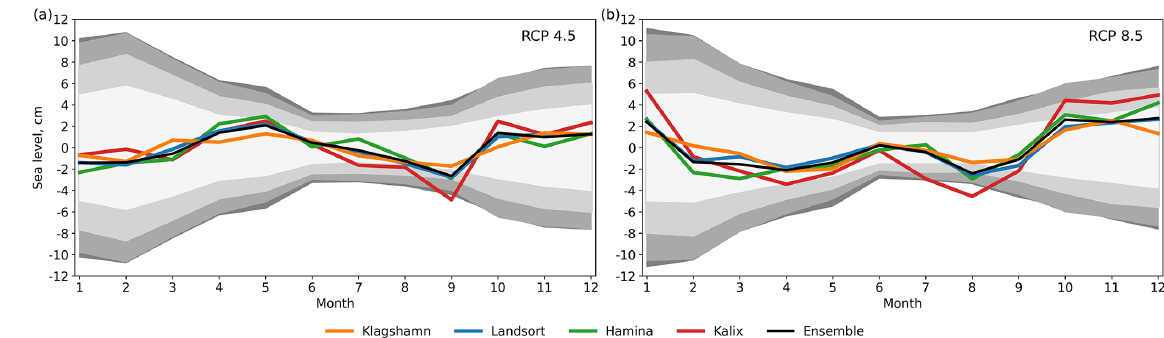
Figure 20. Monthly mean sea level changes between 1976–2005 and 2069–2098 at Klagshamn, Landsort, Hamina and Kalix (for the locations, see Fig. 1) for RCP4.5 (a) and RCP8.5 (b) . Shown are the changes relative to the mean sea level rise (a) 0.54m (RCP4.5) and (b) 0.90m (RCP8.5). Shaded areas in white to dark grey denote 99% confidence limits of internal variability at Klagshamn to Kalix respectively. The chosen model approach does not indicate any non-linear effects for scenarios with a larger rise in sea level. (Data source: Meier et al., 2021.) Table 10. As in Table 8 but showing the ensemble mean changes in the summer mean bottom oxygen concentration (in mLL − 1 ) in ECO-